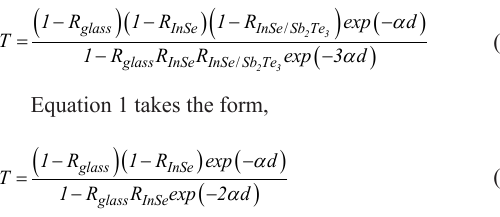
when used for glass/InSe films. α spectra for InSe and InSe/Sb Te films are shown in Figure 2c. 2 3